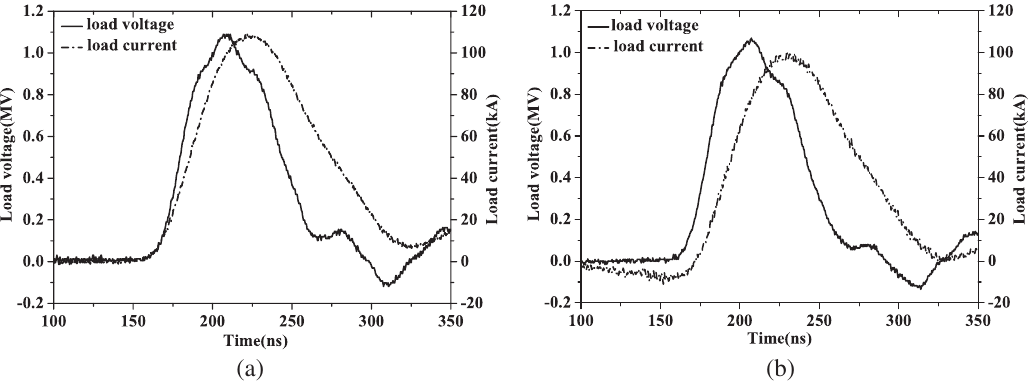
FIG. 9. The load voltage (black solid line) and load current (black dash-dotted line) waveforms detected by the sensors placed on the output transmission line (a) cathode electrode and (b) inner conductor. All the waveforms are obtained by averaging the output signals of the two sensors placed at the same cross section. The rise time of the load voltage waveform is about 28.5 ns and the FWHM is 60.0